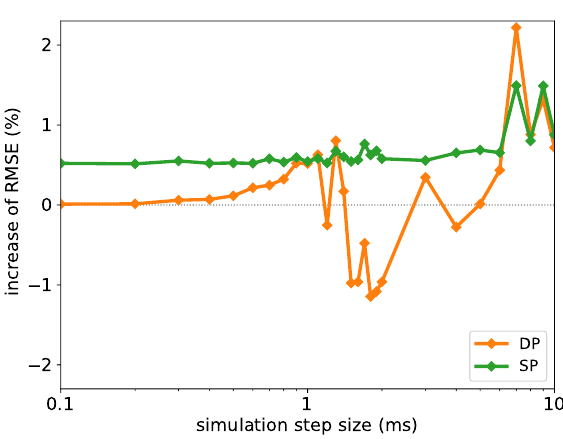
Figure 10. RMSE increase when lowering the inertia constant of the SG